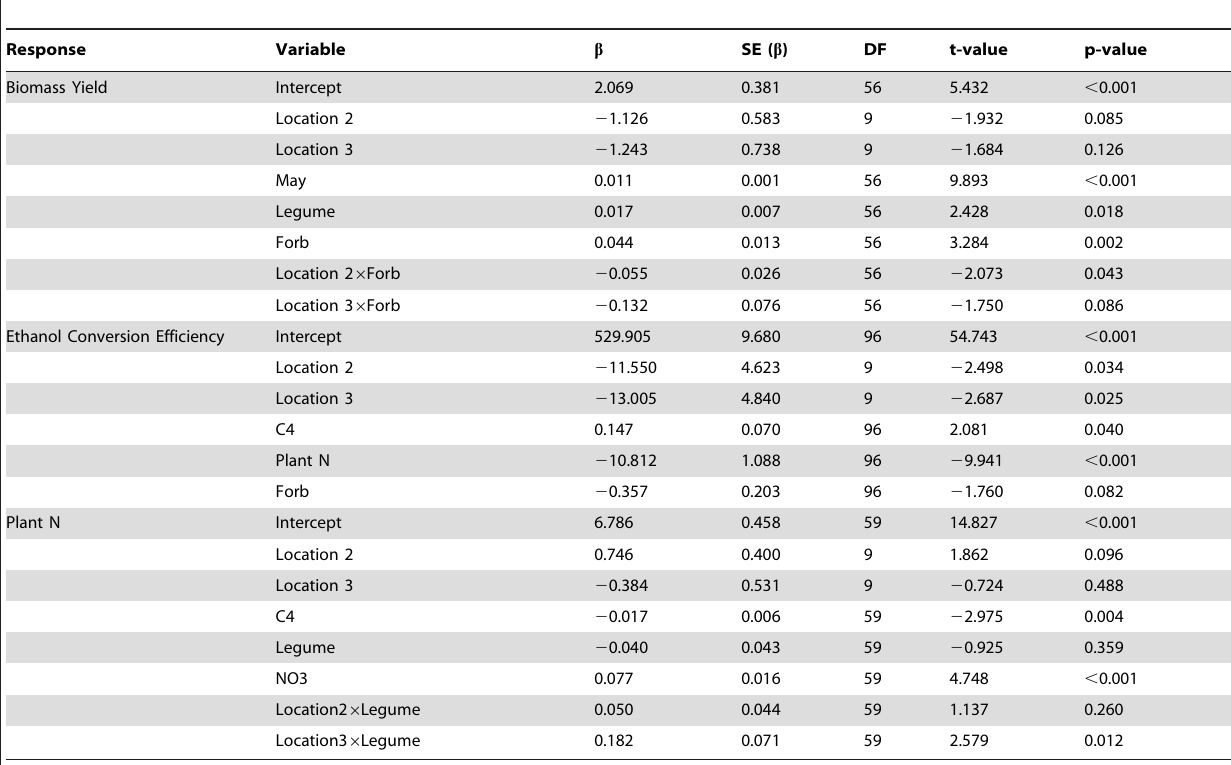
Table 5. Parameter estimates from best-fitted mixed effects models with biomass yield, ethanol conversion efficiency, and plant N as response